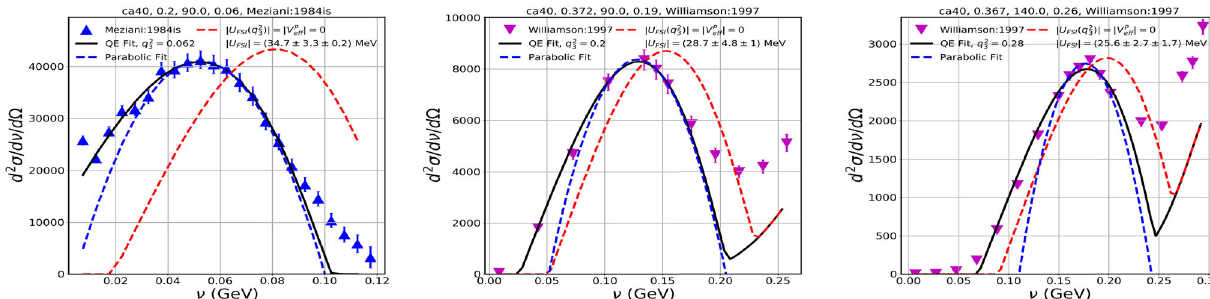
= 0 . 238 GeV) QE differential cross sections Al ( k P F 13